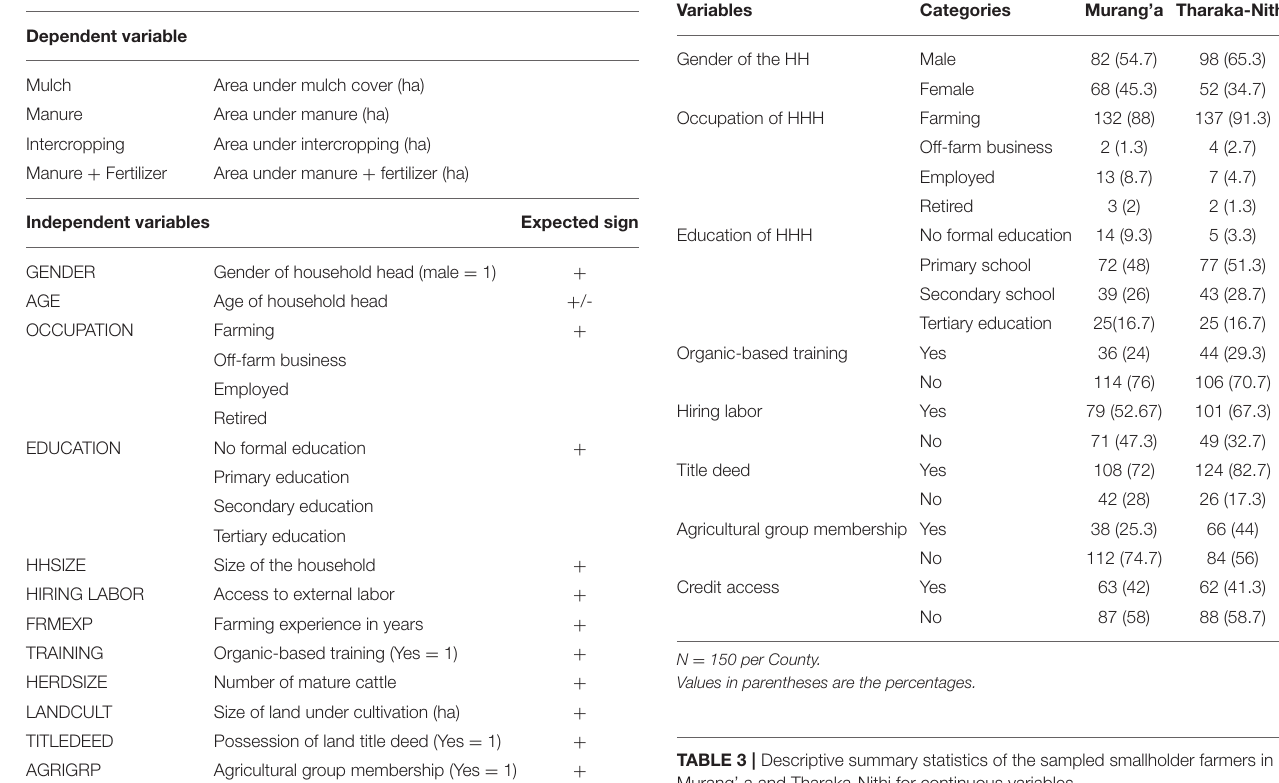
and Tharaka-Nithi for categorical variables. Variables